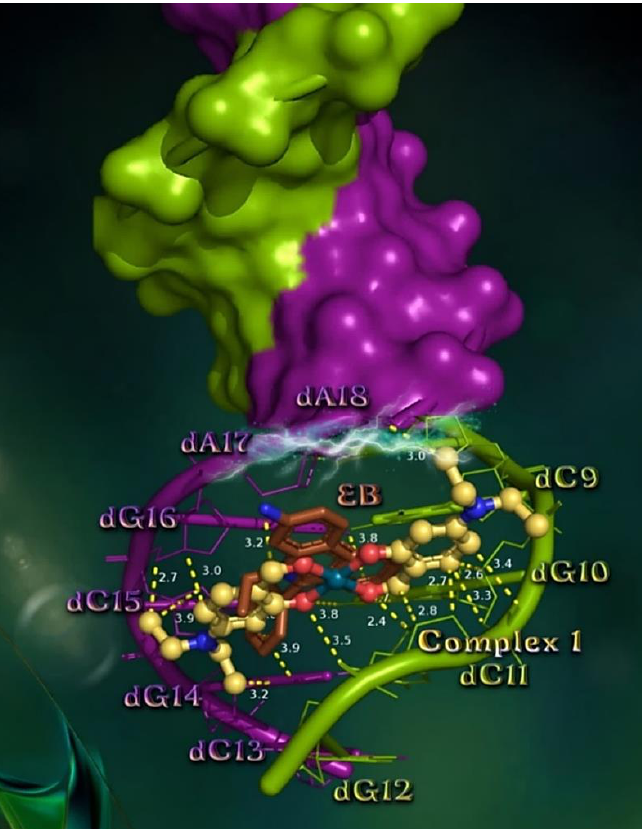
Figure 7. Binding pose architecture of complex 1 and EB in the crystal structure of CT DNA (PDB: 1bna) depicting its stabilization in the binding cavity of the minor groove of DNA. The ligand binding site illustrates the binding interactions of 1 in the crystal structure of CT DNA (lower panel). DNA-structure is illustrated as both opaque surface and cartoon representation, in split pea green and deep purple (clones A and B, respectively). Base pair nucleotides are rendered in line representations and color-coded according to DNA strand color. Docked molecules are rendered in ball-and-stick ( 1 ) and stick (EB) modes colored according to atom type in yellow, orange and brown C atoms, respectively. Dotted lines in yellow indicate hydrogen bond, polar, π –polar type, π –alkyl hydrophobic type and classic hydrophobic interactions, between the docked molecule and the nucleotides in the binding pocket of DNA. Heteroatom color-code: O: red, N: blue, and Pd: deep teal. Hydrogen atoms are omitted from all molecules for clarity. Nucleotides are numbered according to PyMol software. The final structure was ray-traced and illustrated with the aid of PyMol Molecular Graphics System. Binding interactions with nucleotide molecules are shown in Table